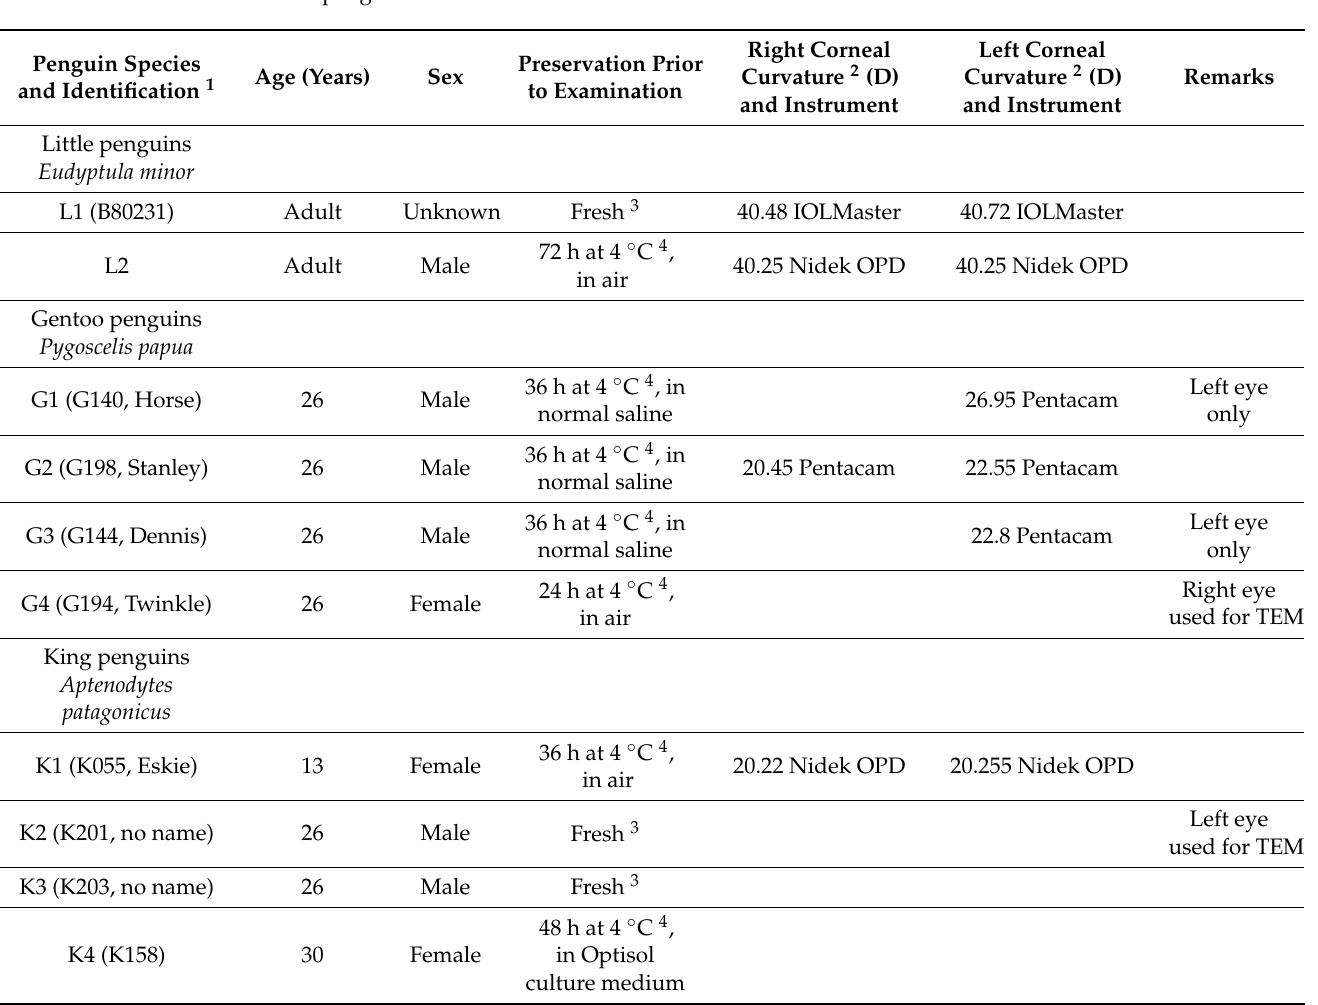
Table 1. Demographic data of penguins including, where known, the names, identification numbers, age at death, sex, storage of the eye until confocal examination and average corneal curvature (including instrument used), for each penguin. The exact ages of birds recovered from the wild were unknown, but all had passed their first moult and are listed as “adult”. Both eyes from the same penguin were examined unless otherwise